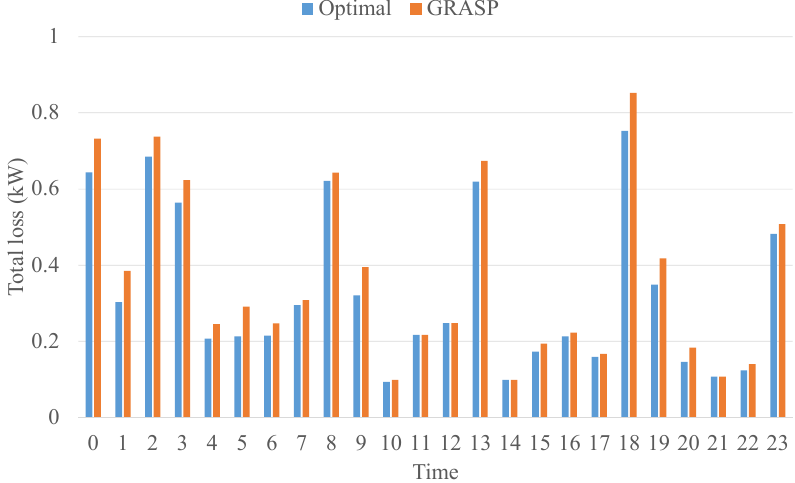
Figure 18. Summary of the costs difference required by GRASP and optimal method in a practical example.